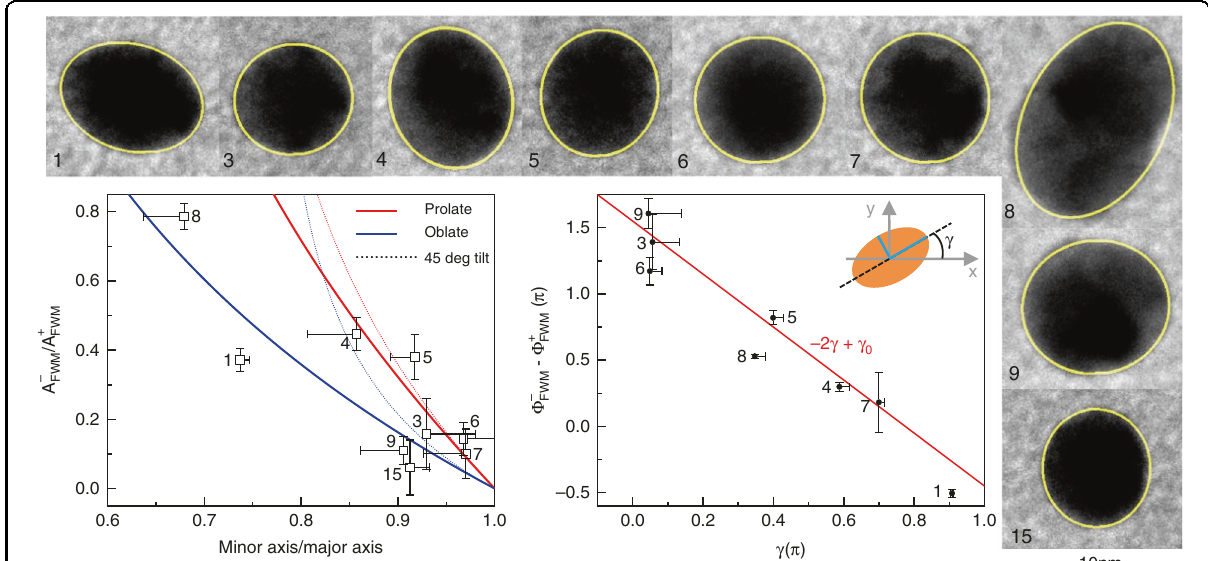
Fig. 2 FWM dependence on the AuNP aspect ratio and orientation. High-magni fi cation TEM images of selected nanoparticles (numbered as in Fig. 1c) were fi tted with an elliptical shape (shown in yellow). AuNP 15 is not captured by the TEM overview in Fig. 1c and is shown in SI Fig. S2 and Fig. S7. The corresponding major and minor axis and the orientation angle γ were obtained (see also sketch). The ratio of the cross- to co-circularly (cid:1) (cid:3) = A þ (cid:1) Φ þ ) and phase Φ (cid:1) is shown versus the in-plane elliptical aspect ratio and orientation polarised FWM components in amplitude ( A (cid:1) FWM FWM FWM FWM angle. Vertical error bars represent the single-pixel shot noise in the FWM measurements. Single-sided horizontal bars were obtained by fi tting the = A þ , red (blue) lines are calculated dependences assuming a prolate (oblate) TEM images with a variable contrast threshold (see text). For A (cid:1) FWM FWM ellipsoid with axis a > b = c ( a < b = c ) aligned along the x, y, z directions respectively. Dotted lines assume that the NP a and c axis are tilted by 45 degrees in the x, z plane, having a projected axis in the x direction as derived in Section